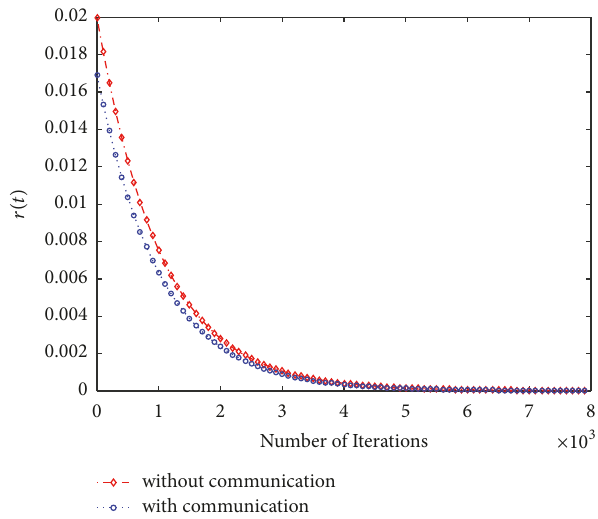
Figure 2: The performance of our algorithm with communication and without